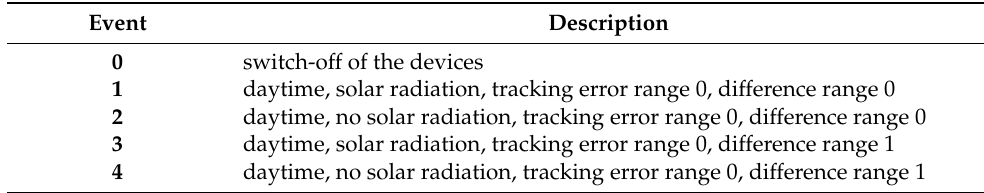
Table 9. Events description (splitter of the thermal control, initial control system). Event Description